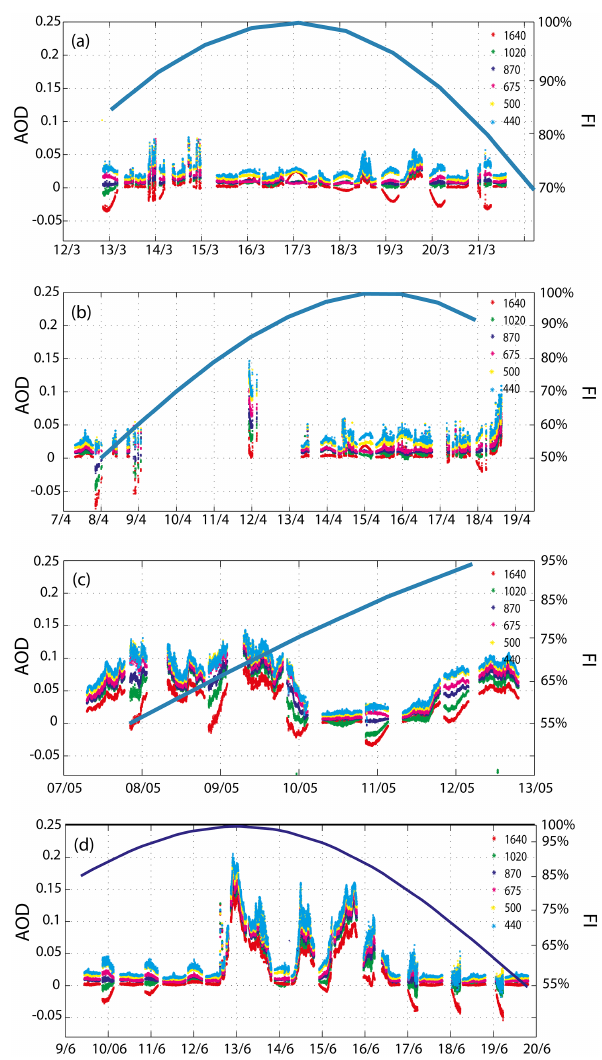
Figure 9. Diurnal CE318-AERONET/CE318-T AOD evolution during (a) March, (b) April, (c) May and (d) June 2014 at IZO. The blue line and right y axis correspond to the evolution in this period of the moon’s factor of illumination